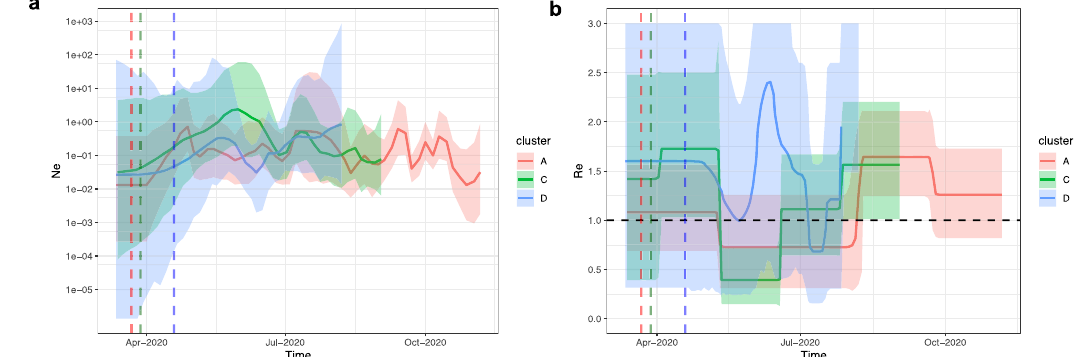
Fig. 5 Bayesian Skygrid and BDSKY analysis reveal spatiotemporal independent population dynamics of Cluster A, C and D. a Estimation of effective population size ( N e ) by Skygrid analysis for Cluster A (red), C (green) and D (blue) sequences. The logarithmic effective number of infections viral generation time ( t ) representing effective transmissions is plotted over time. 95% HPD intervals are plotted in lighter colours. Vertical dashed line is the mean TMRCA. b Estimation of reproductive number ( R e ) by BDSKY analysis of Cluster A (red), C (green) and D (blue) sequences. The shaded portion is the 95% HPD interval, and the solid line is the posterior median. Vertical dashed line is the mean Overall, at least 43 zoonotic transmissions (with 95% HPD (Table S2). Speci fi cally, 27 transmissions of viruses belonging to Cluster A occurred within 13 farms (NB1, NB3, NB8, NB13,